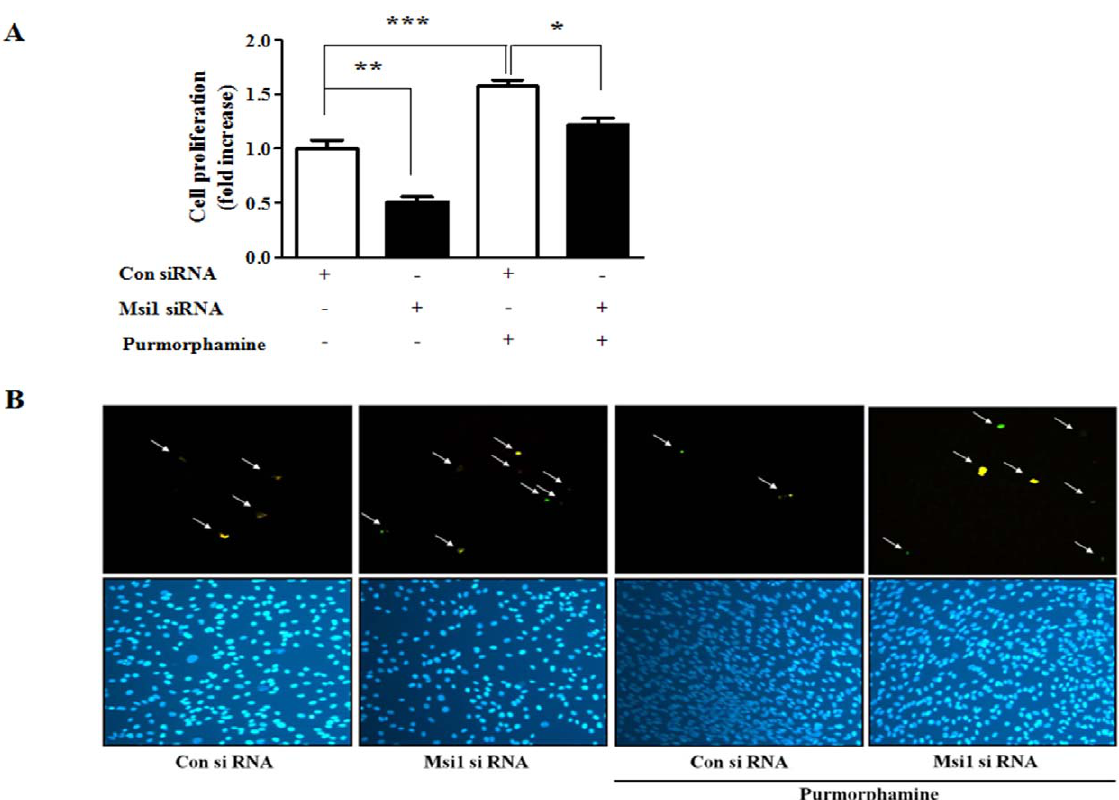
Figure 4. The attenuating effects of Msi1 knockdown on Hh signaling in MSC proliferation and apoptosis. Cells were treated with or without 4 m M purmorphamine and transfected with or without 50 nM Msi1 siRNA. The cell proliferation levels were then evaluated by direct cell counting, and apoptosis levels were assessed with a TUNEL assay and western blotting. Purmorphamine increased cell proliferation ( A ) and decreased TUNEL-positive cell numbers ( B ), while the 50 nM Msi1 siRNA transfection produced the opposite effects. The knockdown of Msi1 attenuated the above effects of purmorphamine treatment. The blue staining (DAPI) identifies cell nuclei. The results are shown as the mean 6 SD from three independent experiments. * P , 0.05, ** P , 0.01, and *** P ,